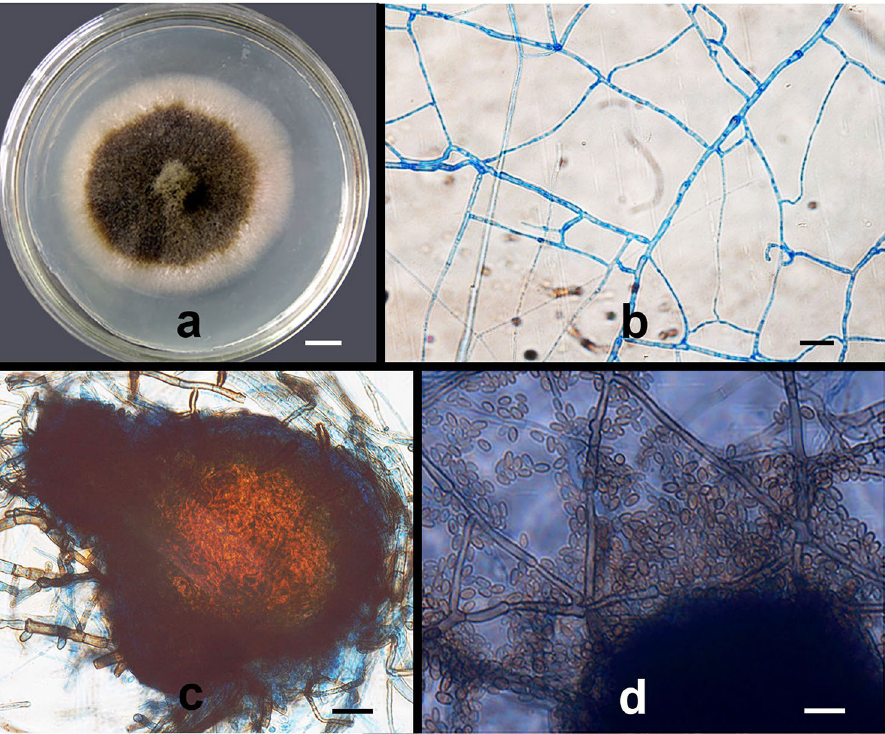
Figure 1. Morphological characteristics of strain PTD37 cultivated on PDA medium. ( a ) A colony after cultivation at 22–23 °C for 10 days. ( b ) Septate hyphae and branches. ( c ) Pycnidium. ( d ) Conidia. Scale bars: ( a ) = 1.0 cm; ( b – d ) = 10